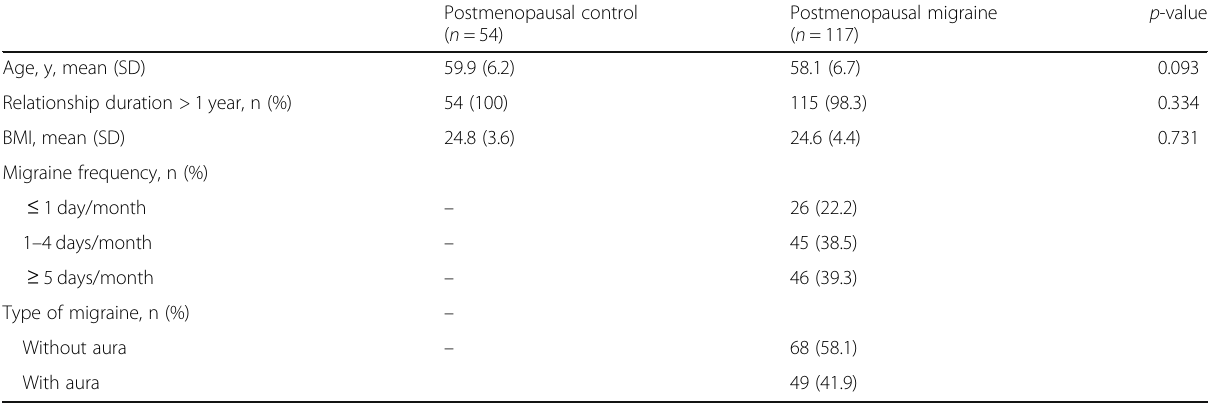
Table 2 Characteristics of the postmenopausal study